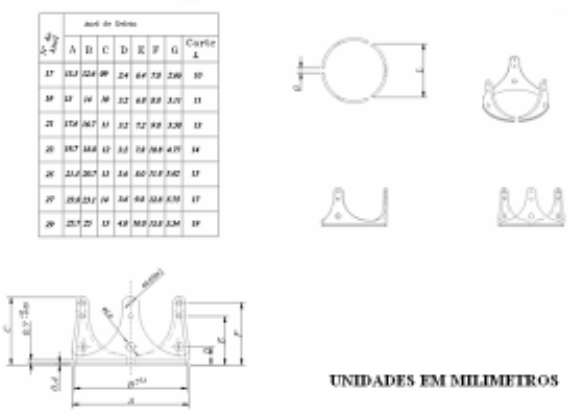
Fig. 2 – Desenho esquemático da bioprótese com respectivas